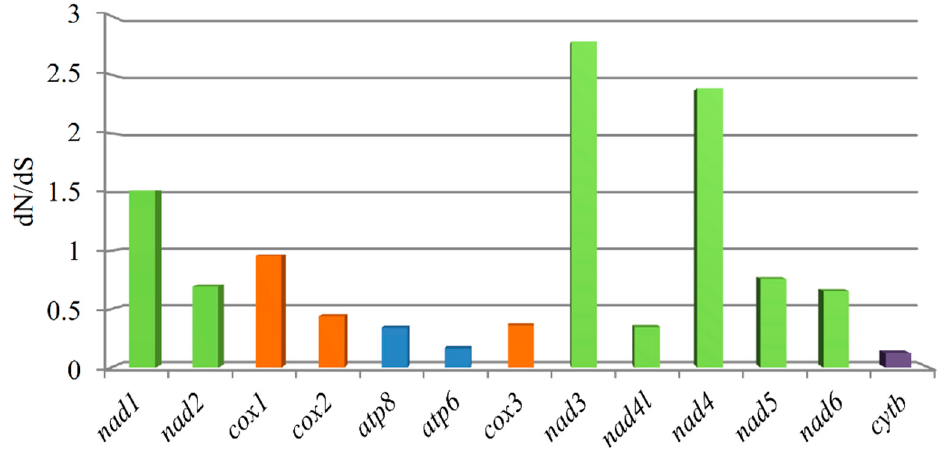
Figure 3. The nonsynonymous/synonymous ratios (dN/dS) in 13 mitochondrial PCGs of 17 species in Idiocerini. The histogram represents the average dN/dS for each PCG.